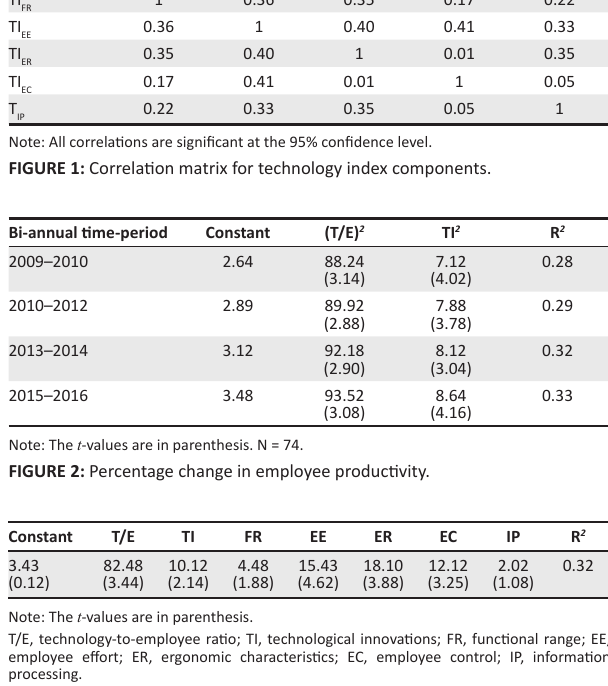
FIGURE 3: Percentage change in employee